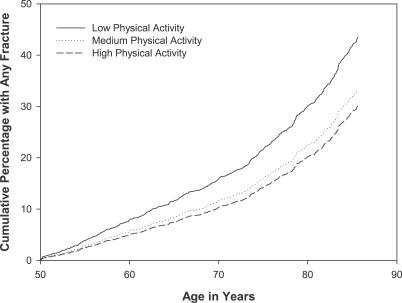
Survival Curves of Participants with Any Type of Fracture after Study Entry at 50 y of Age for the Time-Dependent Low, Medium and High Physical CategoriesSurvival curves are adjusted by changes in physical activity during follow-up.